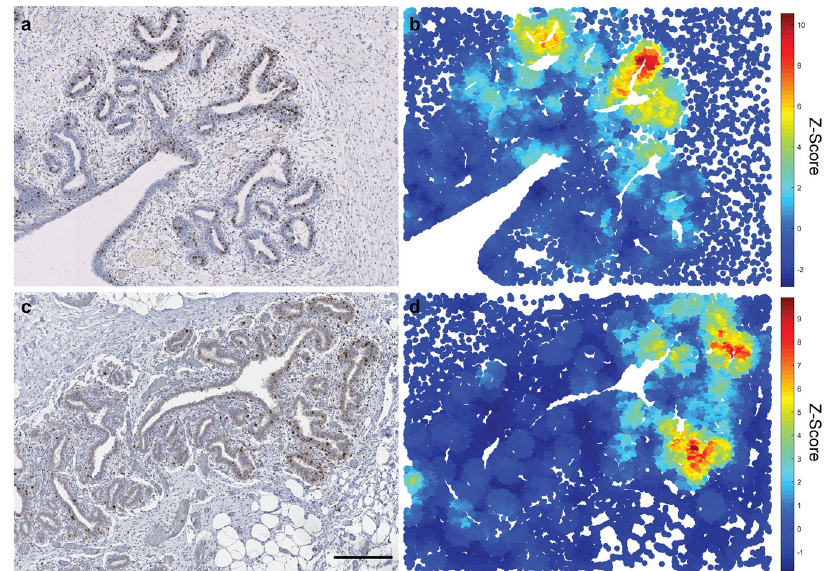
Fig. 3 The developing lamb mammary gland exhibits polarity of Ki67 epithelial expression with Ki67 expression focused at the leading edge of the advancing TDLUs. IHC for Ki67 ( a , c ) and accompanying Getis-Ord (G-O) statistical analyses ( b , d ) demonstrating regions with signi fi cant spatial congregation of intraepithelial Ki67 + cells (scale ( d ) parameter = 250 px). Mammary gland from lambs < 2 mo ( a , b ) and 5-9.5 mo ( c , d ); mo, months old. a , c Haematoxylin counterstain. Scale bar = 200 μ m. b , d Results are representative of three biological